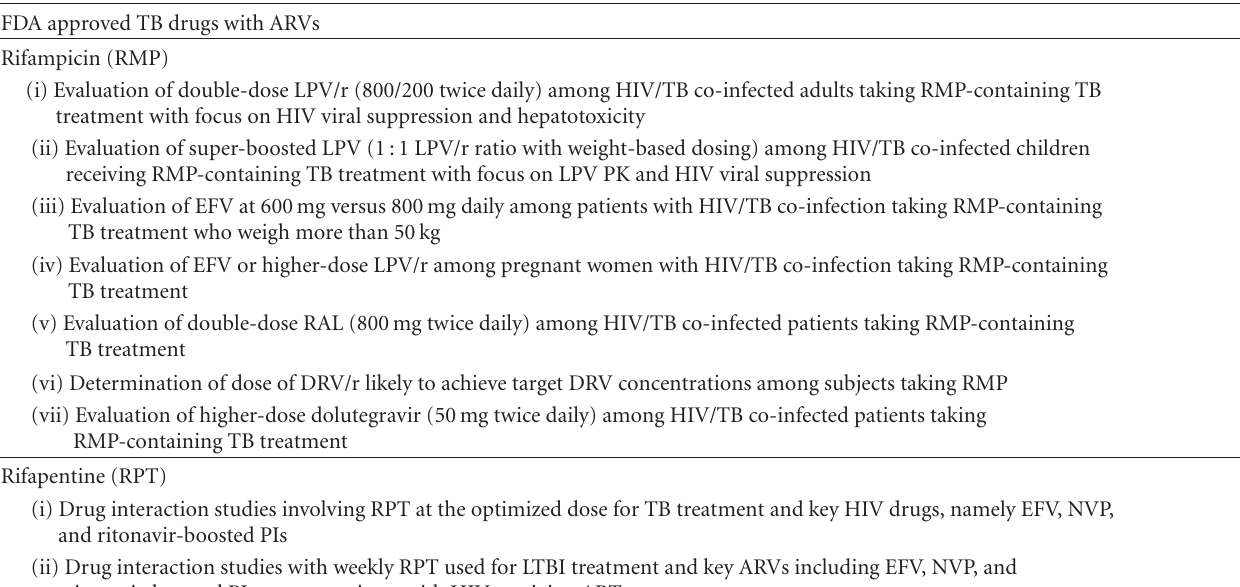
Table 1: High priority TB-HIV PK or PK/PD